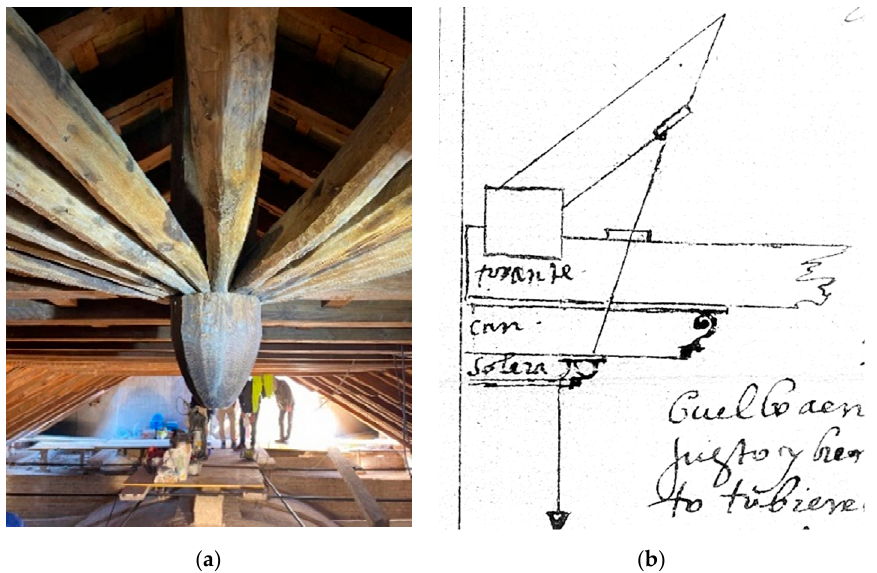
Figure 1. ( a ) Joint of traditional timber frame carpentry, located in the case of study; ( b ) details of the joint between the rafter, wall plate, tie beam, and the wall, according to the medieval manual. It is designed to avoid contact between the wall and wall plate [7].